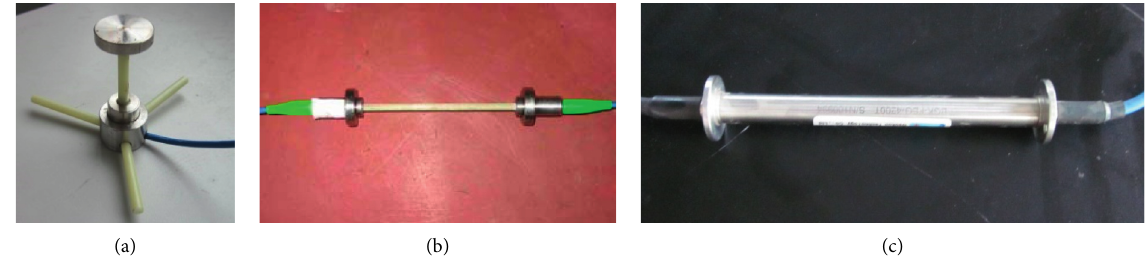
Figure 1: Three types of FBG sensors.(a)FBGS-1; (b)FBGS-2; (c)FBGS-3. Table 1: Parameters for the three types of FBG Sensors.